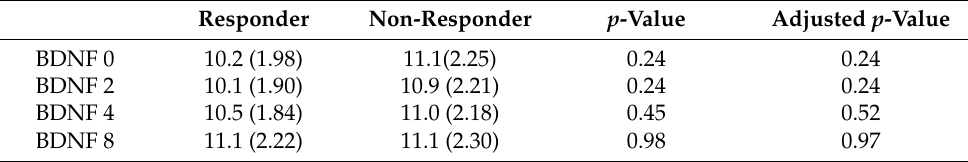
Table 3. Serum BDNF concentrations in treatment responders and non-responders.